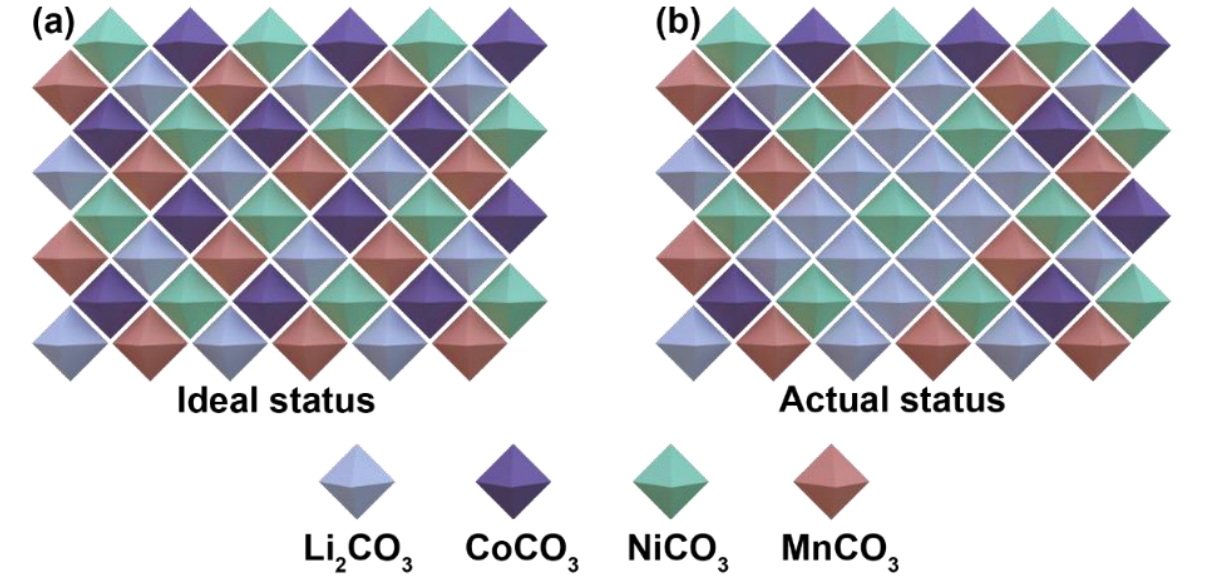
Figure 1. Estimation of the distribution of raw materials: ( a ) ideal status and ( b ) actual status.